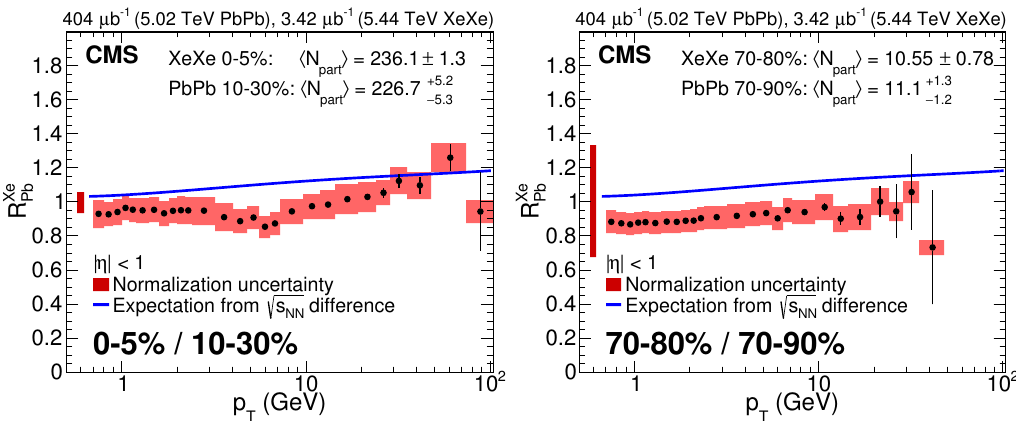
Figure 7 . Measurements of R Xe comparing centrality ranges having similar values of h N part i . Pb The blue line represents the expected deviation from unity caused by the di(cid:11)erent center-of-mass energies of the two collision systems. The solid pink boxes represent the systematic